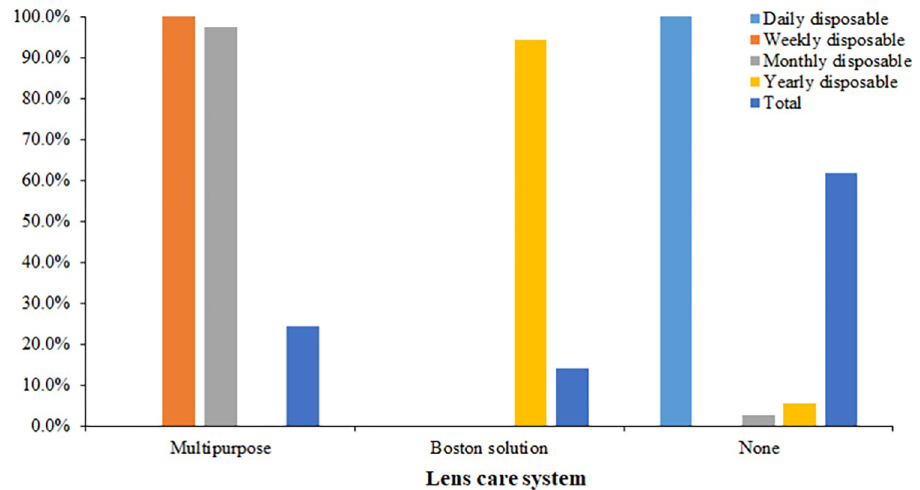
Fig 4. Distribution of contact lens care systems by wear